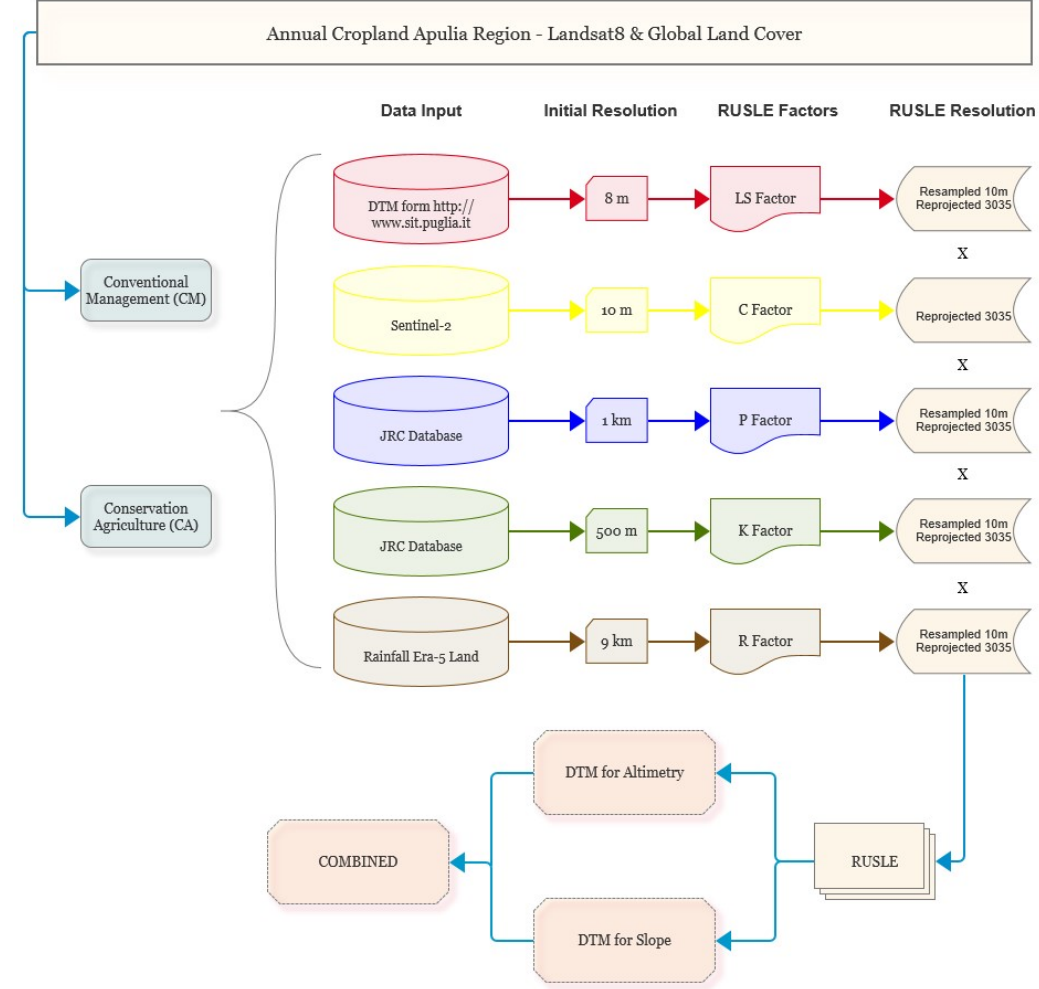
Figure 4. Methodology workflow.